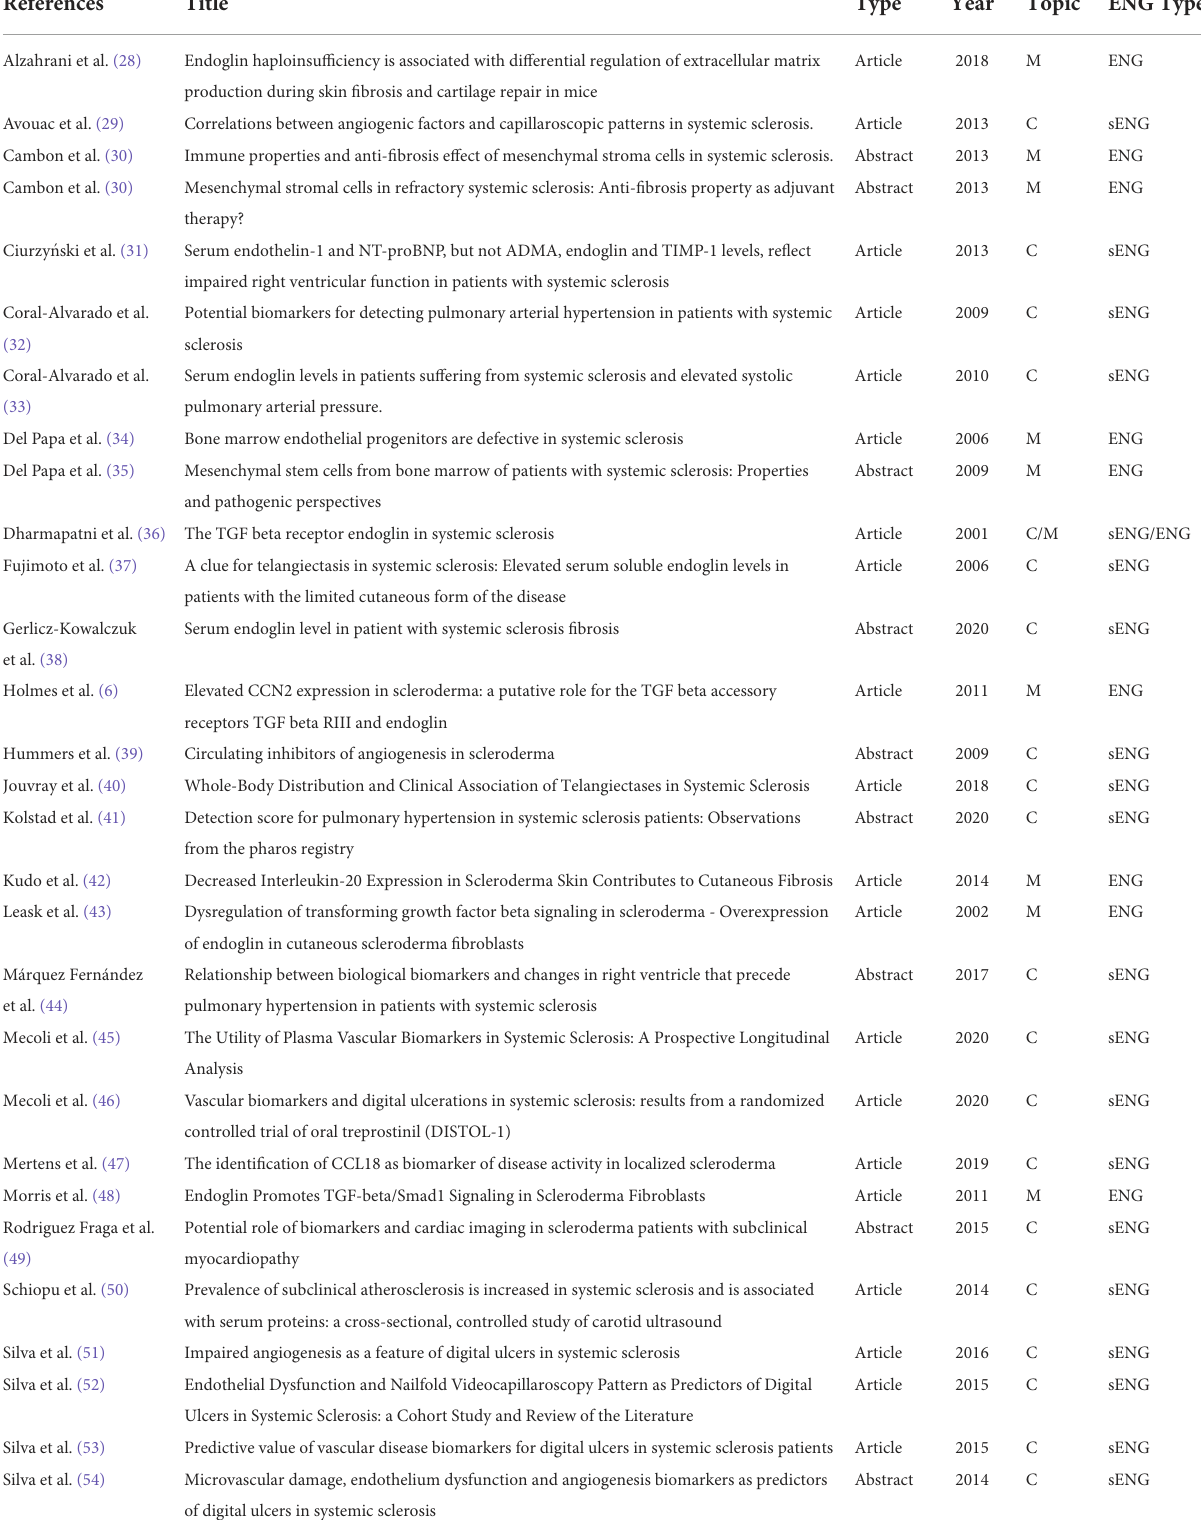
TABLE 1 List of studies selected for the systematic